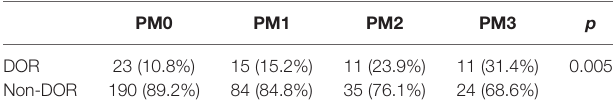
TABLE 4 | Comparison of the proportion of DOR patients among groups. PM0 PM1 PM2 PM3